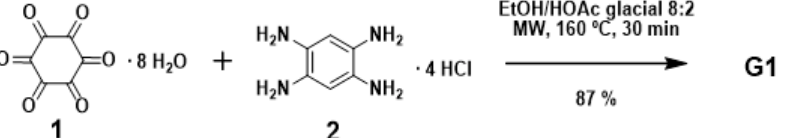
Figure 2. Synthesis of compound G1 .